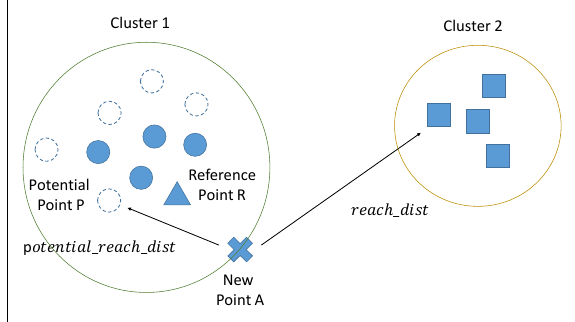
Figure 2. The case of new point to calculate LOF score with point from other